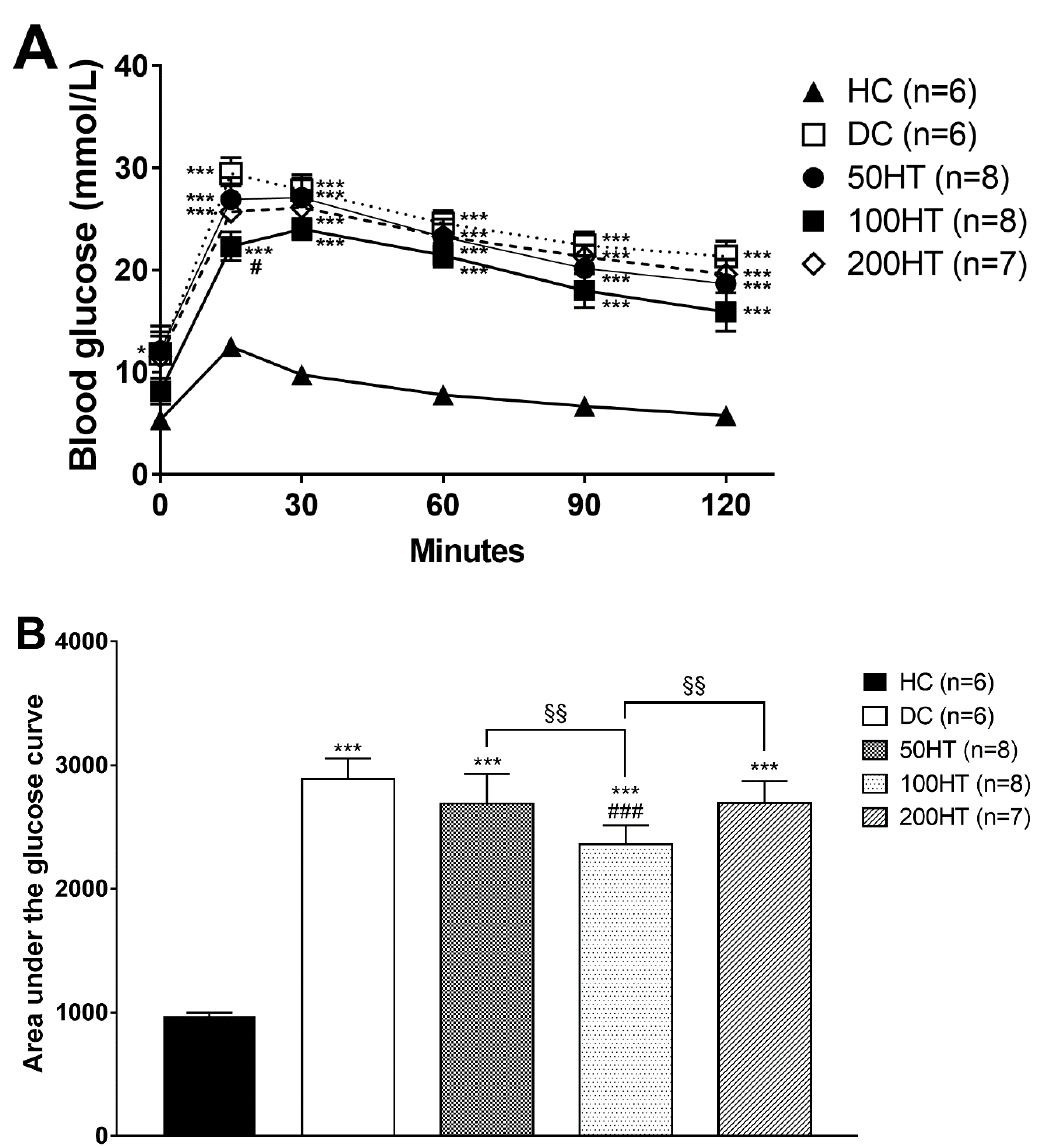
Figure 6. Effect of horsetail on blood glucose levels ( A ) and area under the glucose curve ( B ) during oral glucose tolerance test. The * and *** indicates significant difference from the HC group ( p < 0.05 and p < 0.001, respectively). The # and ### indicates significant difference from the DC group ( p < 0.05 and p < 0.001, respectively). The §§ indicates significant difference between the connected groups ( p < 0.01).